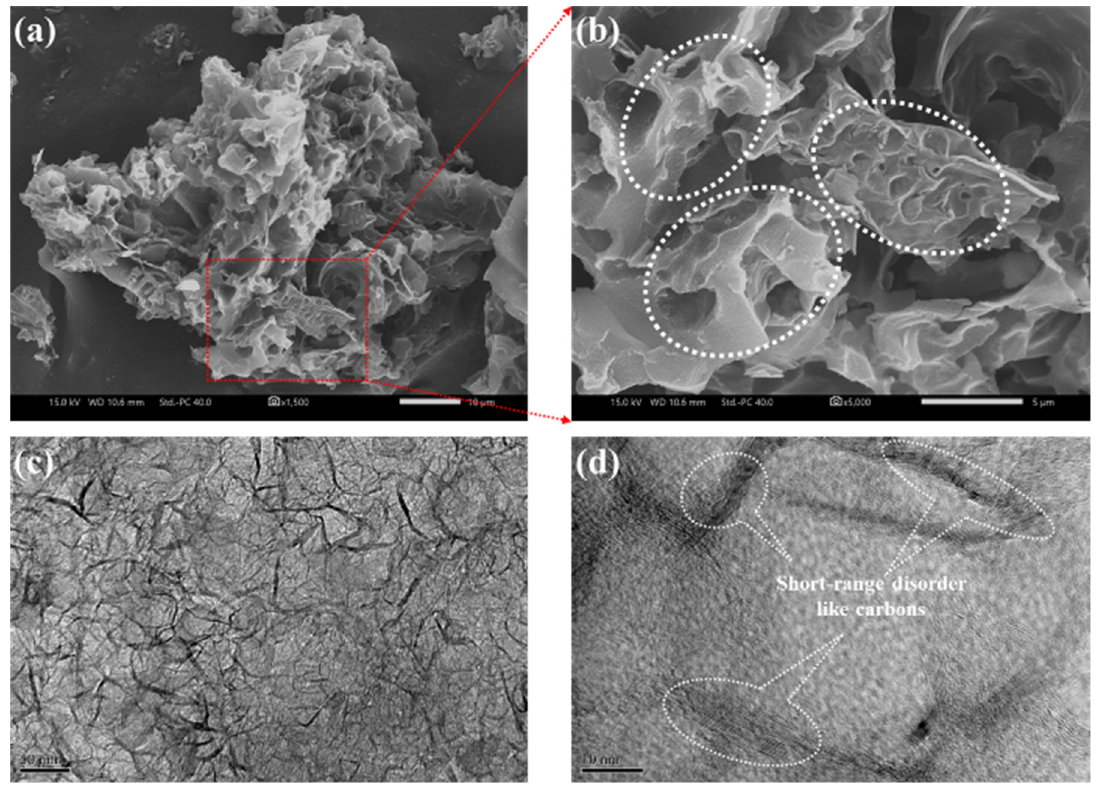
Figure 3. ( a , b ) SEM and ( c , d ) TEM micrographs of the H@H composite material. Scale bar: ( a ) 10 μ m, ( b ) 5 μ m, ( c ) 50 nm, and ( d ) 10 nm. ( b ) 5 µ m, ( c ) 50 nm, and ( d ) 10